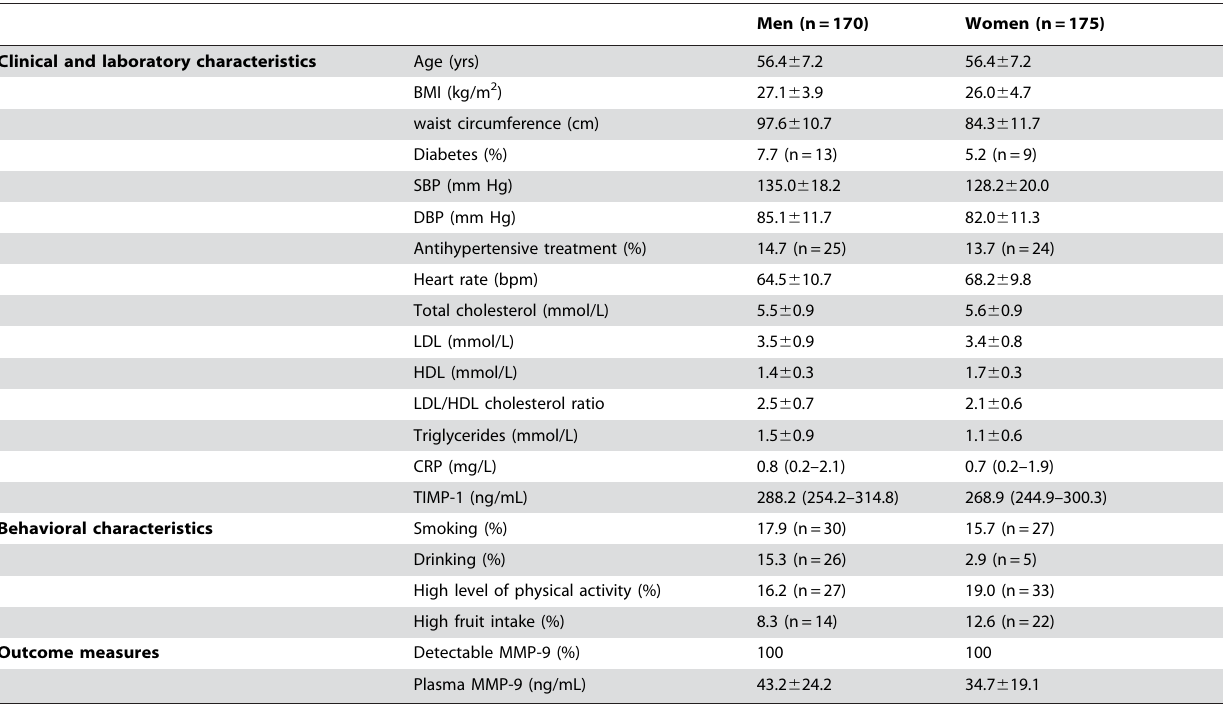
Table 1. Characteristics of study sample, n